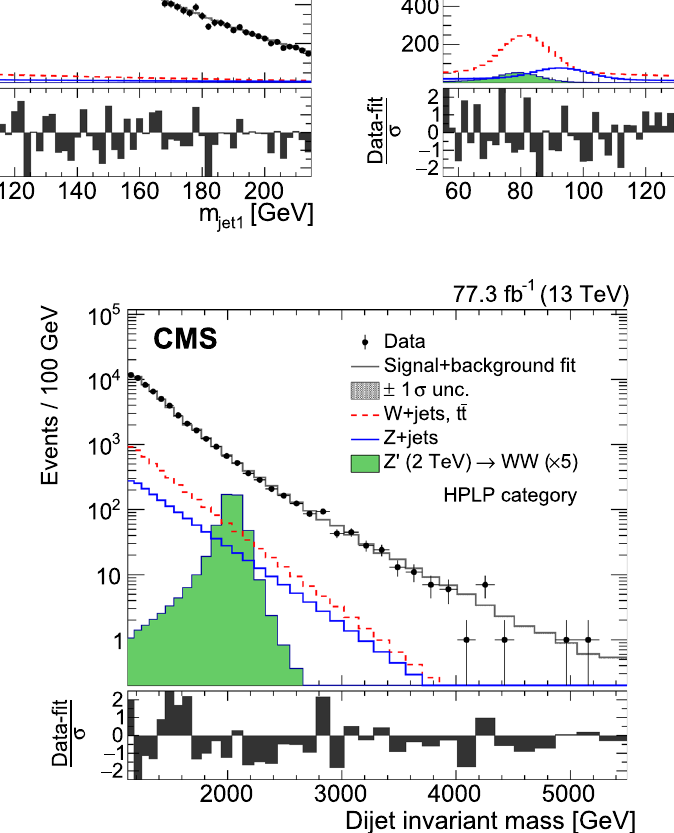
Fig. 11 For the HPLP category: comparison between the sig- nal+background fit and the data distributions of m jet1 (upper left), m jet2 (upper right), and m jj (lower). The background shape uncertainty is shown as a gray shaded band, and the statistical uncertainties of the data are shown as vertical bars. An example of a signal distribution is